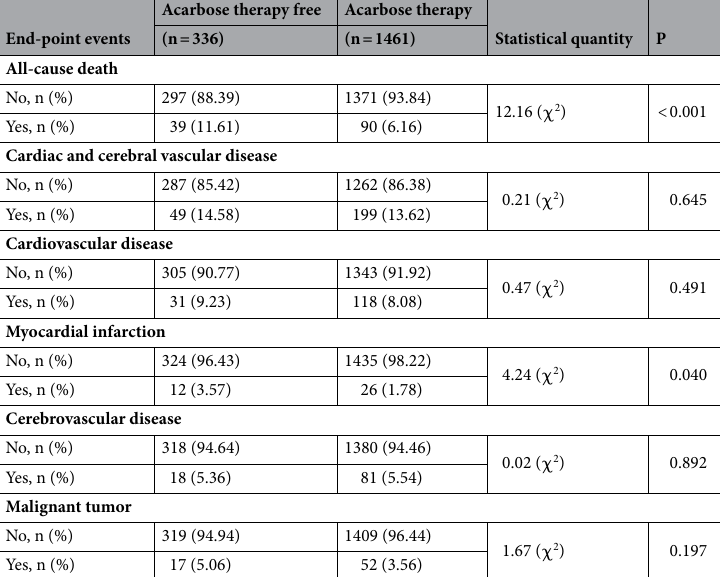
Table 4. The incidence of all-cause end-point events between the two